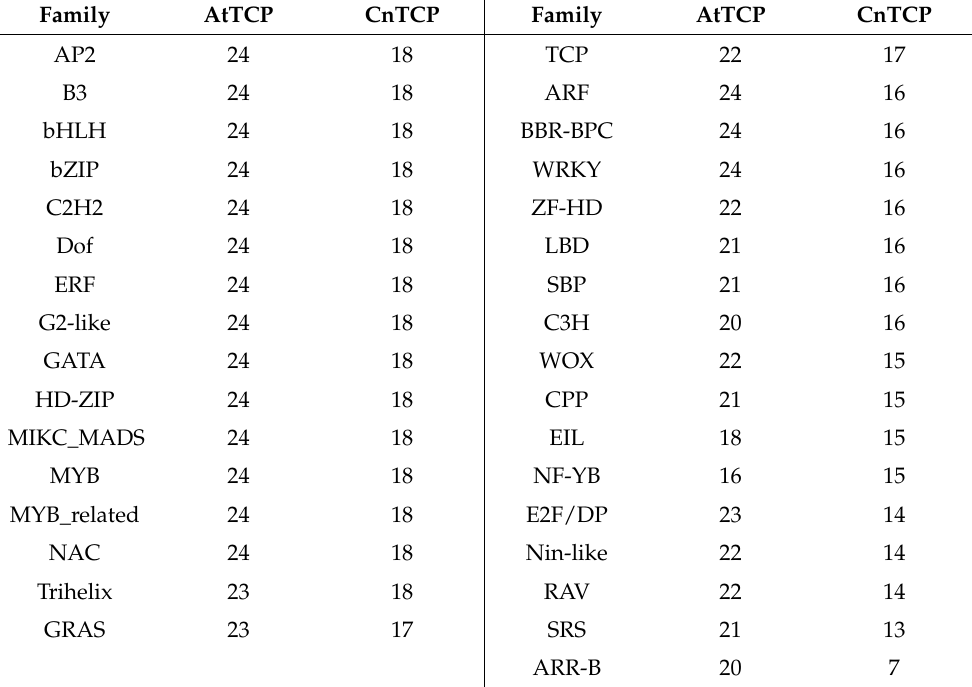
Table 2. Statistical analysis of TFs identified from CnTCP promoter